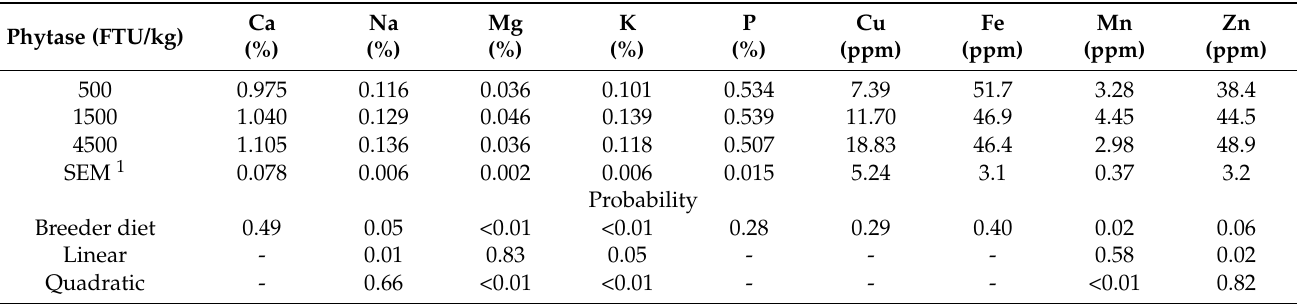
Table 7. Mineral concentration of yolks sac collected from one day-old chicks of broiler breeders fed superdoses of phytase from 27 to 50 weeks of